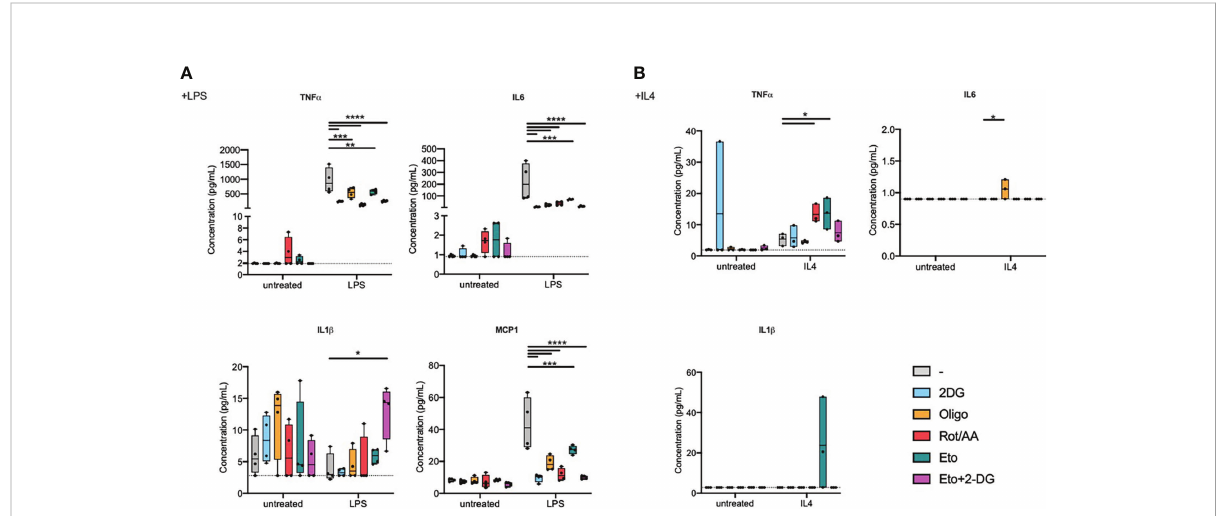
FIGURE 2 Metabolic inhibitors alter macrophage secretory pro fi le in response to LPS or IL4. Bone marrow-derived macrophages (BMDMs) were pretreated with metabolic inhibitors for 30 min before being stimulated with M1 (LPS) or M2 (IL4) stimulus or left untreated for 2 h. Macrophage response was then assessed by quantifying cytokine concentration in the extracellular medium. (A) Concentration of TNF a , IL6, IL1 b and MCP1 in cell culture media of BMDMs pretreated with 2-deoxyglucose (2-DG), oligomycin (Oligo), rotenone/antimycin A (Rot/AA), Etomoxir (Eto) or a combination of 2-DG and Etomoxir (Eto+2-DG) and then stimulated with LPS for 2h. (B) Concentration of TNF a and MCP1 in cell culture media of BMDMs pretreated with 2DG, Oligo, Rot/AA, Eto or Eto+2-DG and then stimulated with IL4 for 2h. All points are shown in box plots with line at median. The dashed line indicates detection limit of the assay. One-way ANOVA was used to determine statistical signi fi cance between groups within each stimulation condition (untreated, LPS, IL4) *p < 0.05, **p < 0.01, ***p < 0,001, ****p < 0,0001. Unless otherwise stated, differences between groups are not statistically signi fi